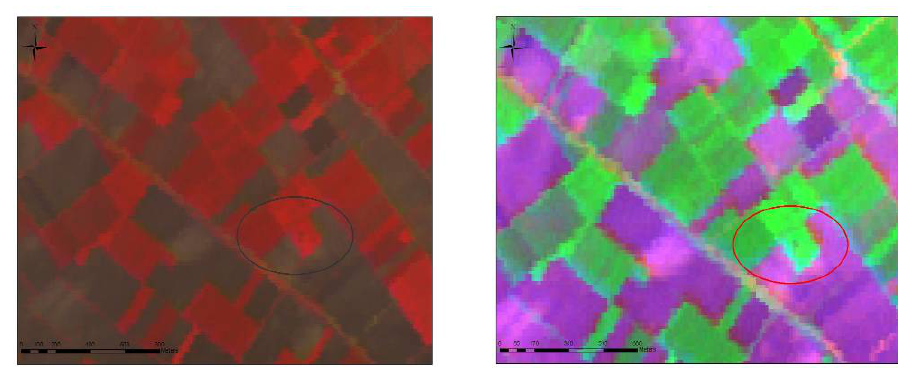
Figure 3. RGB → 3,2,5 of ASTER image –Melisa Settlement 1 (left). RGB → 2,3,7 of ASTER image – Melisa Settlement 1